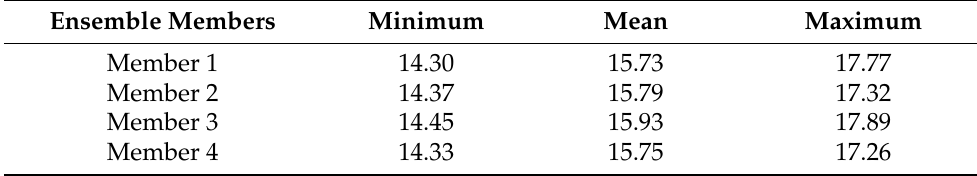
Table 5. Summary of minimum, mean, and maximum RMSE (mm) values for the bias-corrected daily rainfall from 1979–2018 for each ensemble member in Table 1.